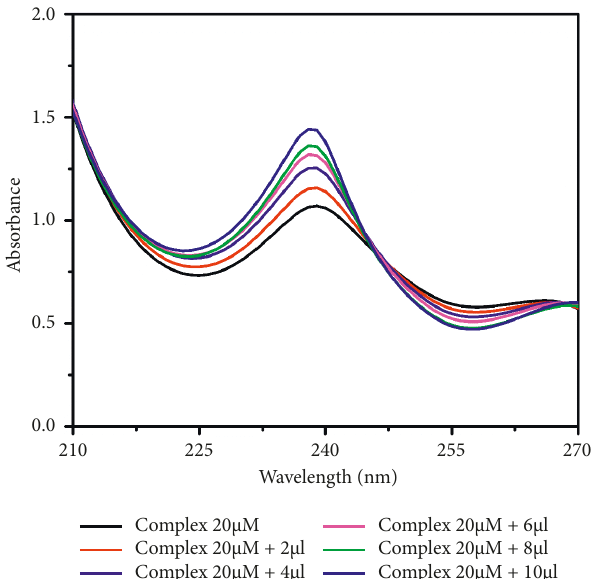
Figure 3: UV-absorption titration of complex 2 (20 µ M) with 0.2 mM CT-DNA in 10 mM Tris-HCl buffer (pH 7.2).